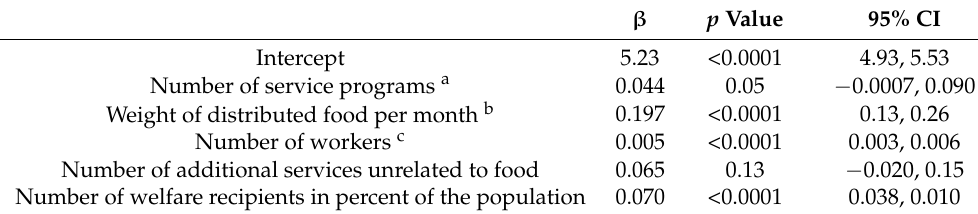
Table 2. Association between the log-transformed number of food bank users and food bank resources and district character. Results of multiple linear regression analyses.